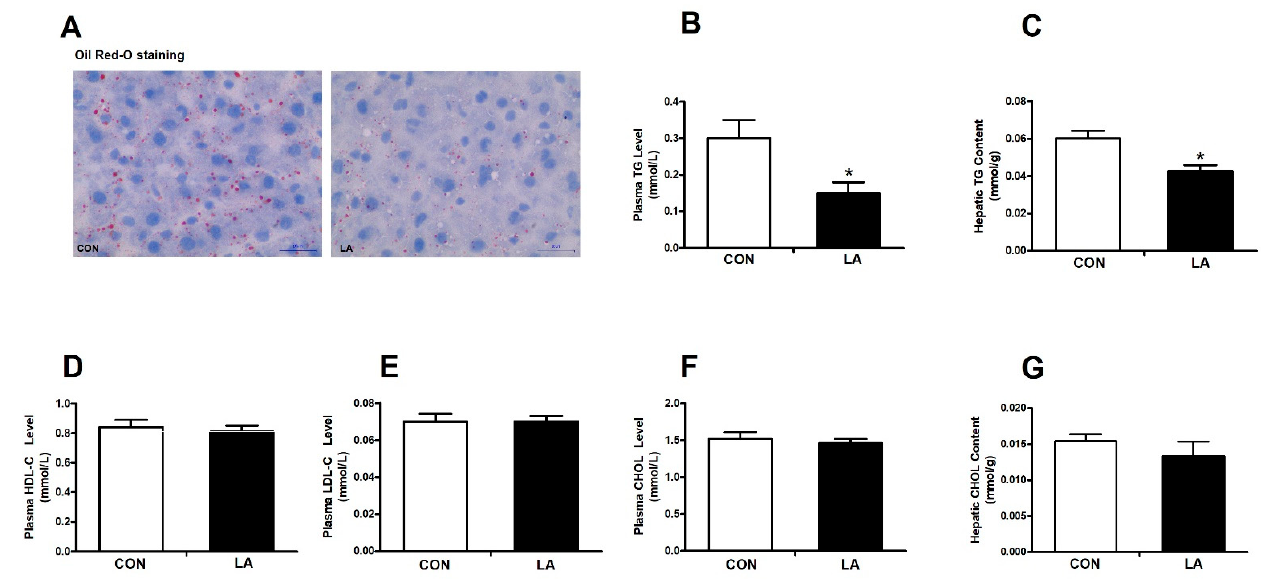
Figure 1. Effect of α -lipoic acid on lipid metabolism in rats. ( A ) Oil Red-O staining of a liver section (magnification, 400 × ). ( B ) Plasma triglyceride levels. ( C ) Hepatic triglyceride contents. ( D ) Plasma high-density lipoprotein levels. ( E ) Plasma low-density lipoprotein levels. ( F ) Plasma cholesterol levels. ( G ) Hepatic cholesterol contents. CON: Control diet, LA: Control diet+ alpha-lipoic acid. Values are expressed as mean ± SEM, n = 12 in each group, * p < 0.05.